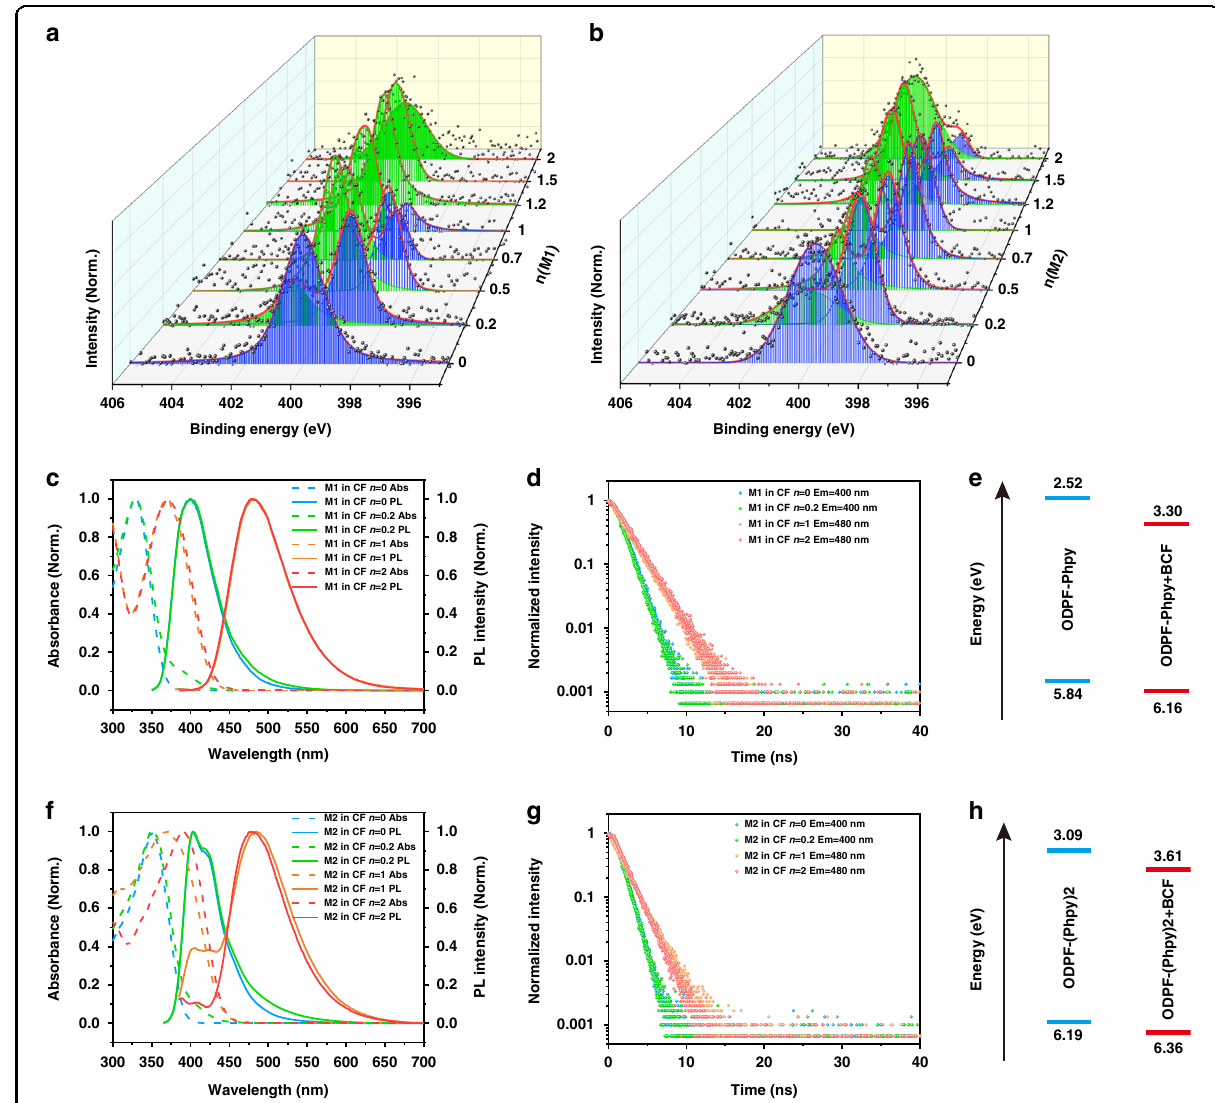
Fig. 1 The basic properties of original compounds and coordinated compounds. a Binding energy of N-1s region for M1 blending fi lms. b Binding energy of N-1s region for M2 blending fi lms. Shades of green: coordinated N atoms. Shades of blue: uncoordinated N atoms. c Abs and PL spectra of M1 with n = 0, 0.2, 1 and 2 in CF. Concentration: 10 -5 mol L – 1 . d Fluorescent lifetime of M1 with n = 0, 0.2, 1 and 2 in CF (10 -5 mol L – 1 ). The lifetime was 1.22 ns, 1.24 ns, 2.15 ns and 2.18 ns, respectively. e The HOMO and LUMO energy of ODPF-Phpy and ODPF-Phpy + BCF. f Abs and PL spectra of M2 with n = 0, 0.2, 1 and 2 in CF. Concentration: 10 -5 mol L – 1 . g Fluorescent lifetime of M2 with n = 0, 0.2, 1 and 2 in CF (10 -5 mol L – 1 ). The lifetime was 1.01 ns, 1.02 ns, 1.79 ns and 1.56 ns, respectively. h The HOMO and LUMO energy of ODPF-(Phpy) 2 and ODPF-(Phpy) 2 +